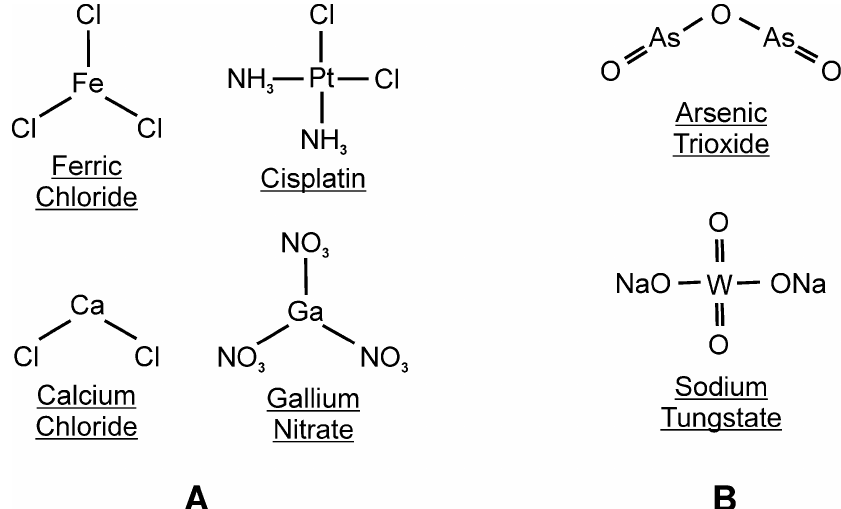
Figure 1. Structures of various metal-containing compounds. Panel ( A )—the metal cation contained in these four compounds is likely to directly bind to protein targets. Panel ( B )—the metalloid and metal depicted in these two molecules are not likely to directly interact with proteins. As = arsenic, Ca = calcium, Cl = chloride, Fe = iron, Ga = gallium, Na = sodium, NH 3 = ammonia, NO 3 = nitrate, O = oxygen, Pt = platinum and W = tungsten.